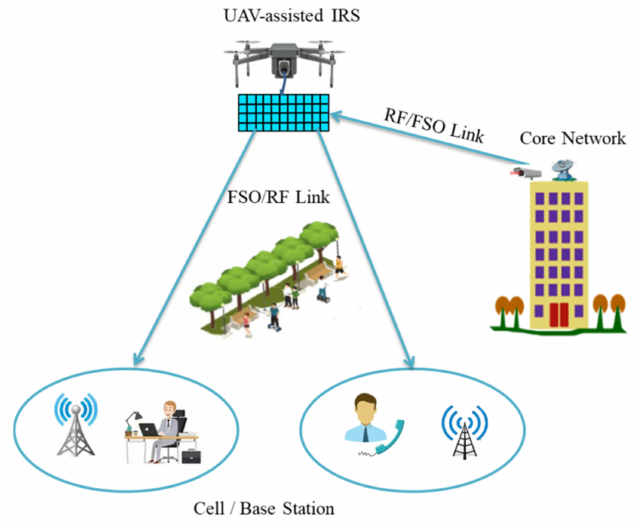
Figure 9. UAV-based IRS-assisted RF/FSO